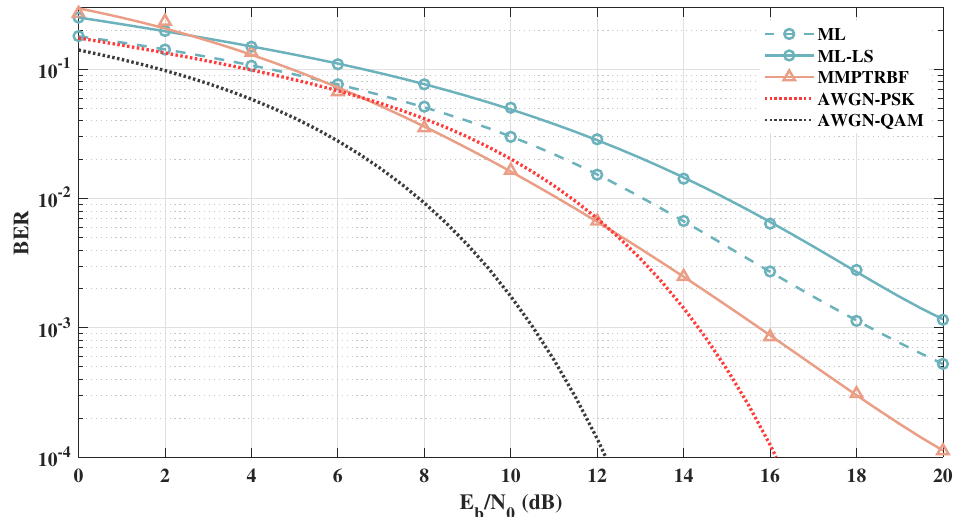
Figure 21. Systems with M T = M R = 4 antennas operating at the same bitrate with 16-QAM (MMPTRBF) and 16-PSK (ML-QOSTBC and